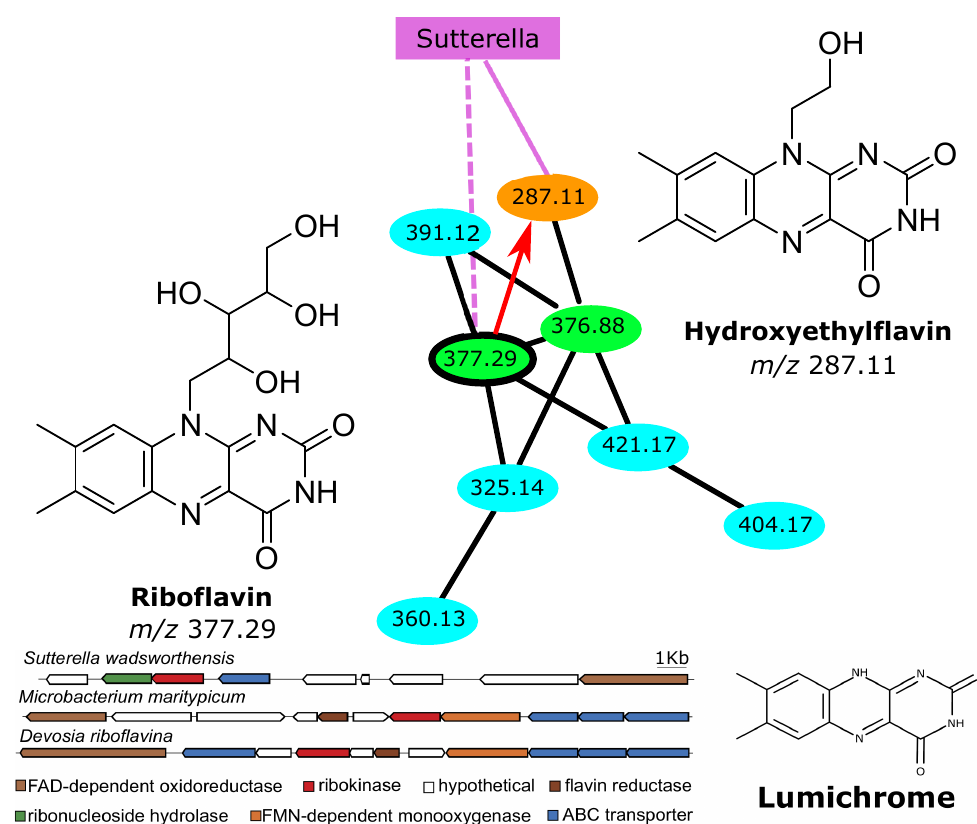
Figure 3. One of the molecular features (orange circle) in the molecular network (same color scheme as in Figure 2) is specific to AGP, and Dereplicator+ [34] identified it as hydroxyethylflavine, a known product of the degradation of riboflavin by an unknown microbial enzyme in gut microbiota [37]. A microbial feature annotated as Sutterella wadsworthensis is positively correlated with this product and negatively correlated with riboflavin (highlighted green circle). The predicted riboflavin degradation gene cluster in Sutterella wadsworthensis is shown, along with two known riboflavin degradation gene clusters from Microbacterium maritypicum and Devosia riboflavina . Sutterella wadsworthensis is predicted to degrade riboflavin to hydroxyethylflavine, while the other two bacteria degrade it to